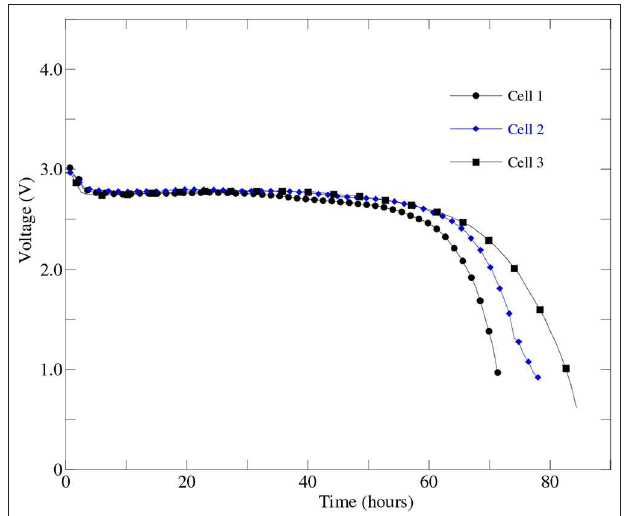
FIGURE 8 | The first discharge profiles of three optimized battery cells those were prepared from the same batch of optimized cathode, HBP electrolyte, and anode materials at 0.1mA discharge current.